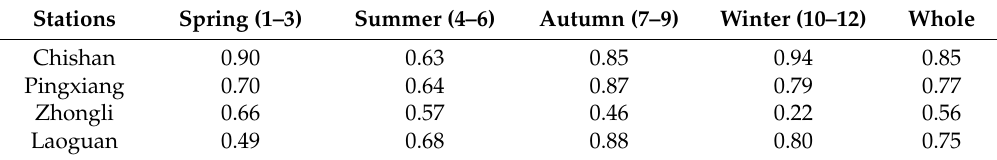
Table 1. Correlation coefficient between Shangli and adjacent stations in Xiangjiang River, Jiangxi